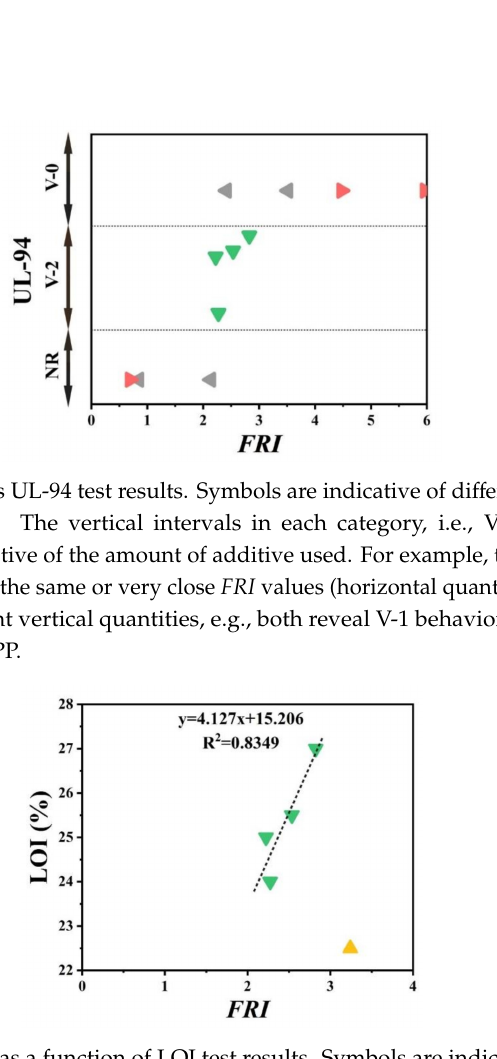
Figure 13. FRI values of PP as a function of LOI test results. Symbols are indicative of di ff erent types of bio-based flame retardant used. The green triangles are related to a mixture of phytic acid and piperazine-based FR. The increase of LOI is directly related to the percentage of FR loading, 15, 18, 20, and 25 wt.%.